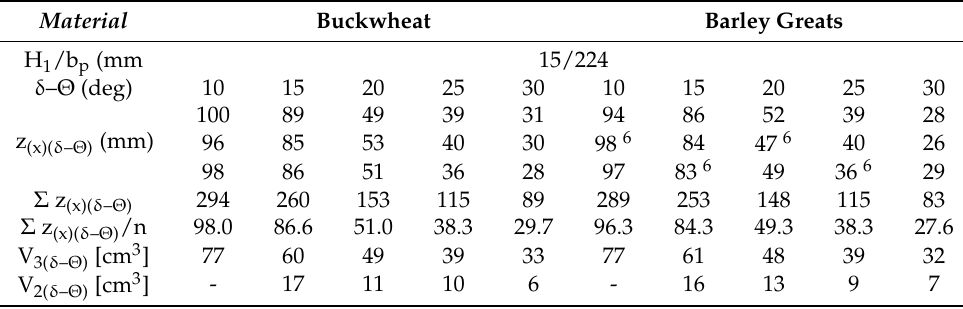
Figure 12. Batch volume V i [cm 3 ] of barley groats spread on the surface of the conveyor belt at H 1 = 15 mm. Length of the distribution z (x) for ( δ–Θ ) (deg) ( a ) 10 deg, ( b ) 15 deg, ( c ) 20 deg and ( d ) 25 deg.